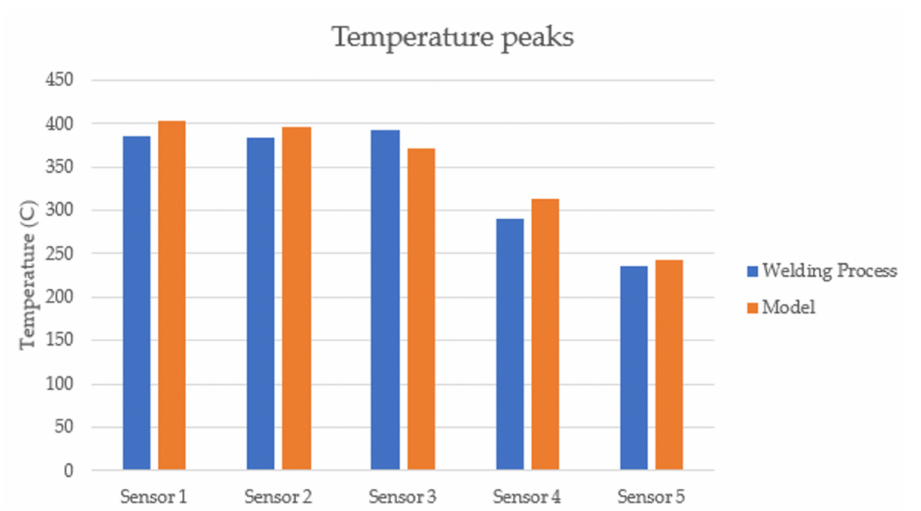
Figure 13. Visualization of the temperature peaks for each thermocouple. These temperature predictions give confidence that the material flow generated by